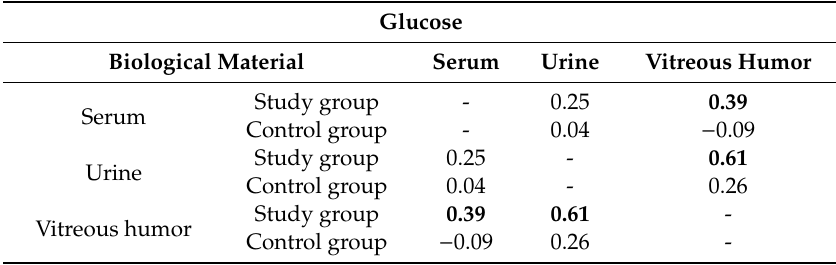
Table 10. Correlation between glucose concentration in di ff erent biological materials. Significant correlations are in bold.